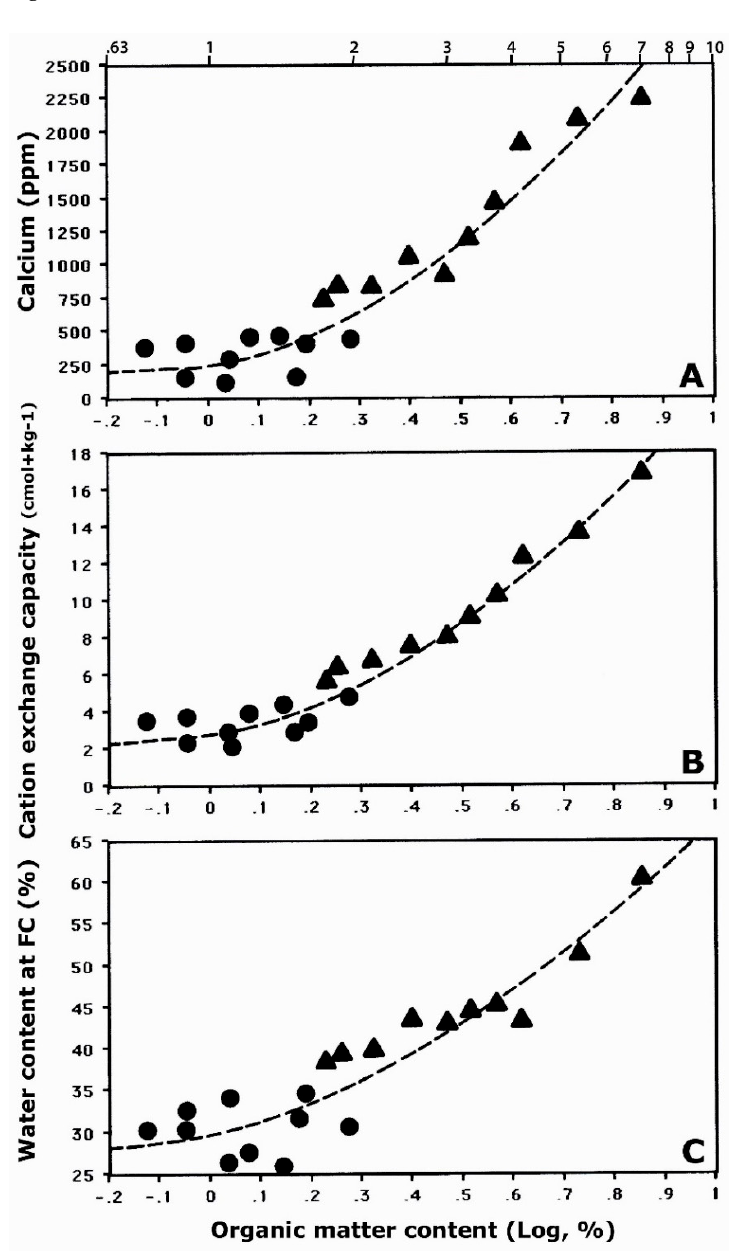
Figure 9. Relationship between soil organic matter (SOM) (log 10 -transformed percentage) and various soil properties for 20 paired samples. Key . Triangles: Samples under k ū paoa; circles: Adjacent bare (control) soils. Dashed lines represent slopes of individual polynomial regressions; upper graph legend shows untransformed SOM percentages. ( A ) Available Ca 2+ (ppm), Y = 286.791 + 784.089X + 2057.979X 2 , R = 0.959, R 2 = 0.920, p < 0.001. ( B ) Cation-exchange capacity (CEC) (cmol + kg − 1 ), Y = 3.097 + 4.798X + 13.537X 2 , R = 0.983, R 2 = 0.966, p < 0.001. ( C ) Soil water content % at field capacity (WRC, − 33 kPa), Y = 30.352 + 12.472X + 24.462 X 2 , R = 0.916, R 2 = 0.839, p < 0.001.